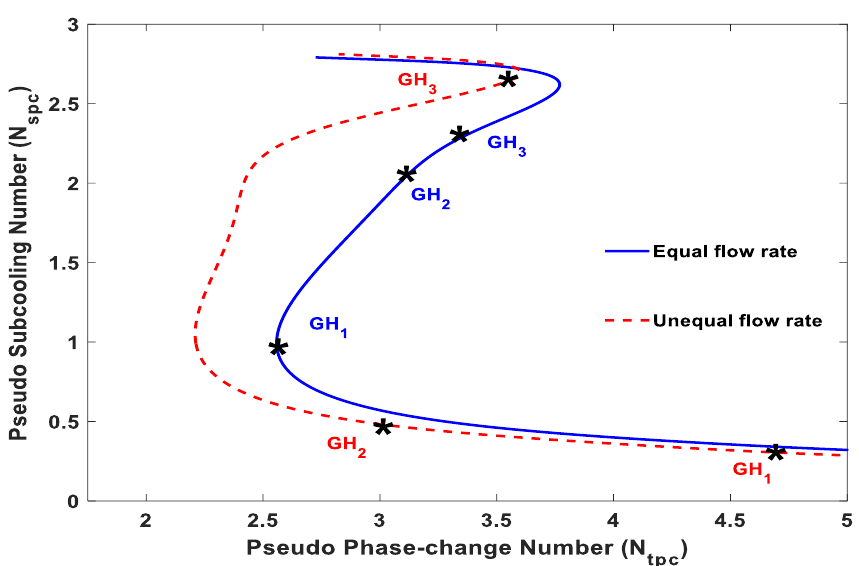
Figure 9. Stability threshold in the N tpc − N spc space for supercritical carbon dioxide at ℎ 𝑓𝑑 = 1.1 .